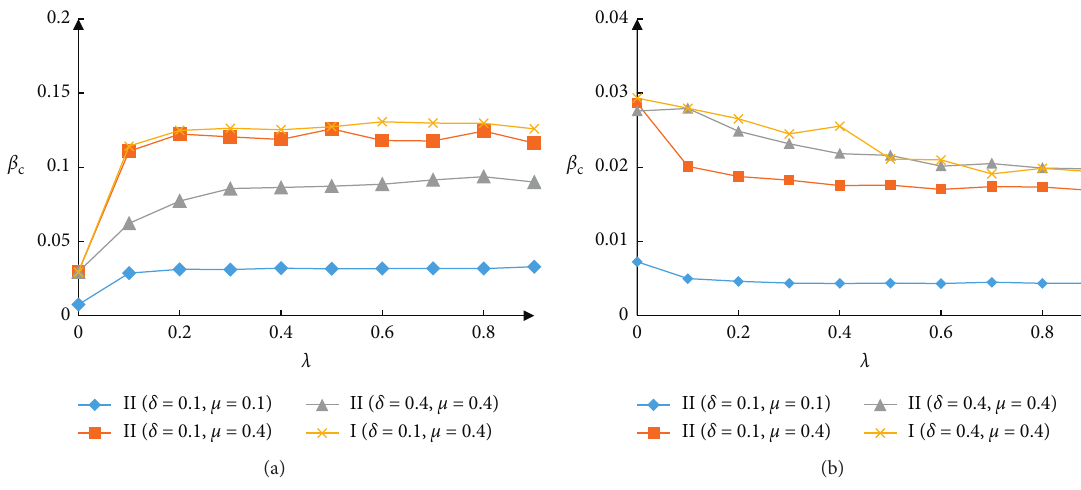
Figure 6: The influence of λ on β